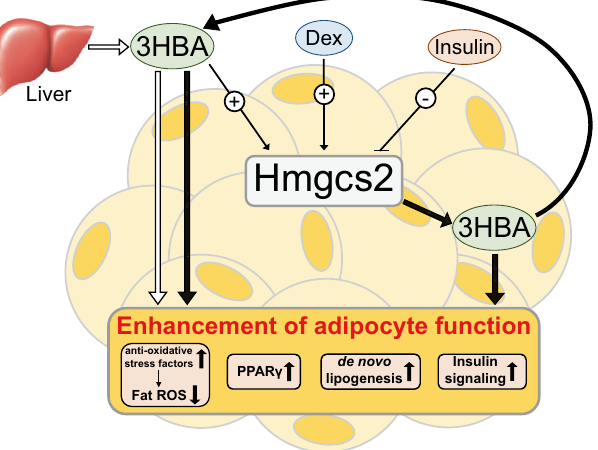
Figure 8. A working hypothesis illustrating how 3HBA contributes to the enhanced function of adipocytes. Circulating 3HBA is primarily synthesized in the liver and secreted. In adipocytes, Hmgcs2 is upregulated by 3HBA and dexamethasone (Dex) but downregulated by insulin. 3HBA enhances the function of adipocytes by reducing fat ROS by inducing antioxidative stress factors and intensifying PPARγ, de novo lipogenesis, and insulin signaling in an endocrine (thick white arrow) and autocrine/paracrine manner through endogenous Hmgcs2 expression followed by the synthesis of 3HBA in adipocytes (thick black